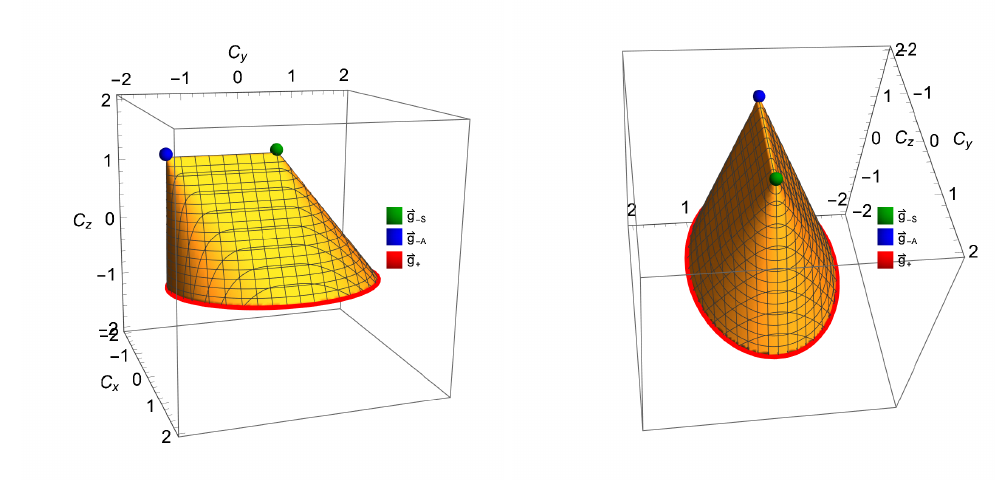
Figure 4. Positivity cone of an EFT with 2 scalars and the Z 2 symmetry. We show a cross section of the cone, in two different angles. The axes are C C z = − C 1 + C 3 − 2 C 4 √ . Generators are labeled by the green and blue dots, and the red C 1 + C 3 + C 4